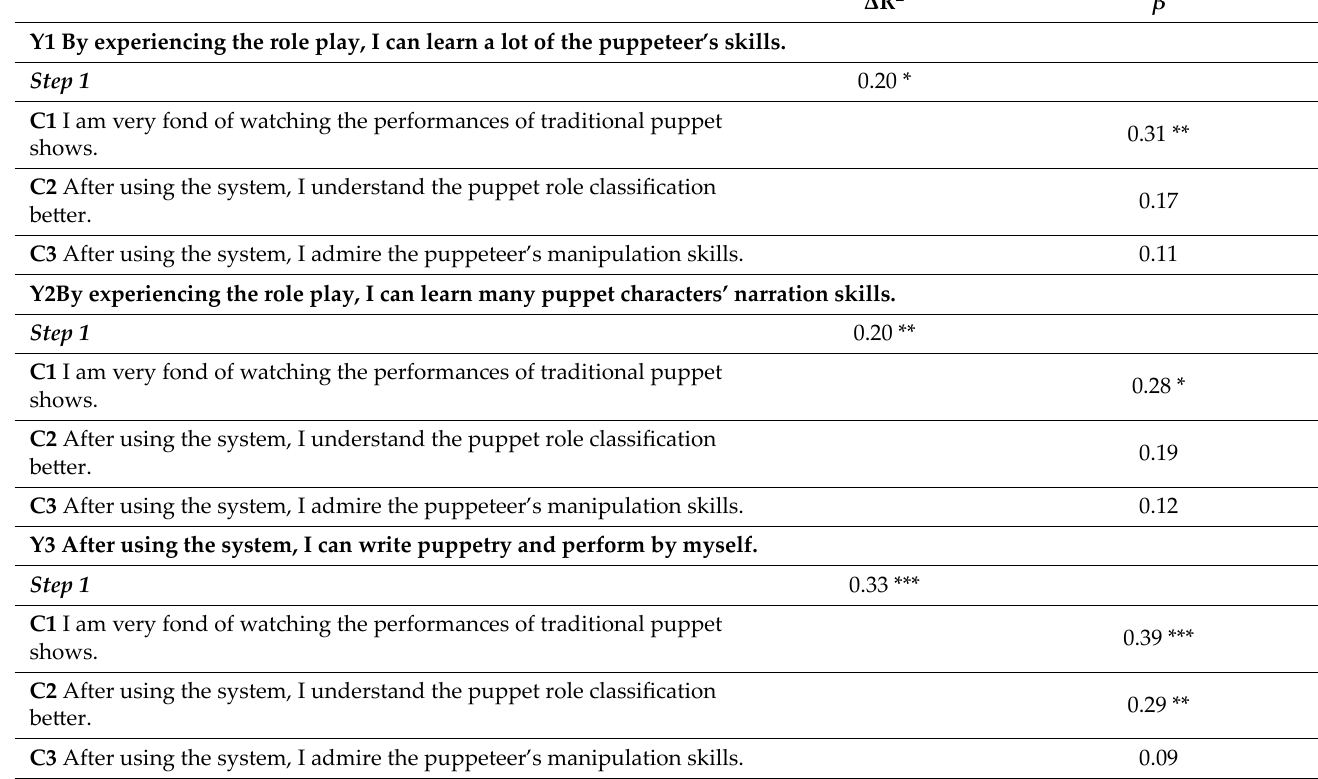
Table 11. The integrated Step 1 regression analysis results with all three of C1 through C3 as the control variables and one of Y1 through Y6 as the dependent variable. ∆ R 2